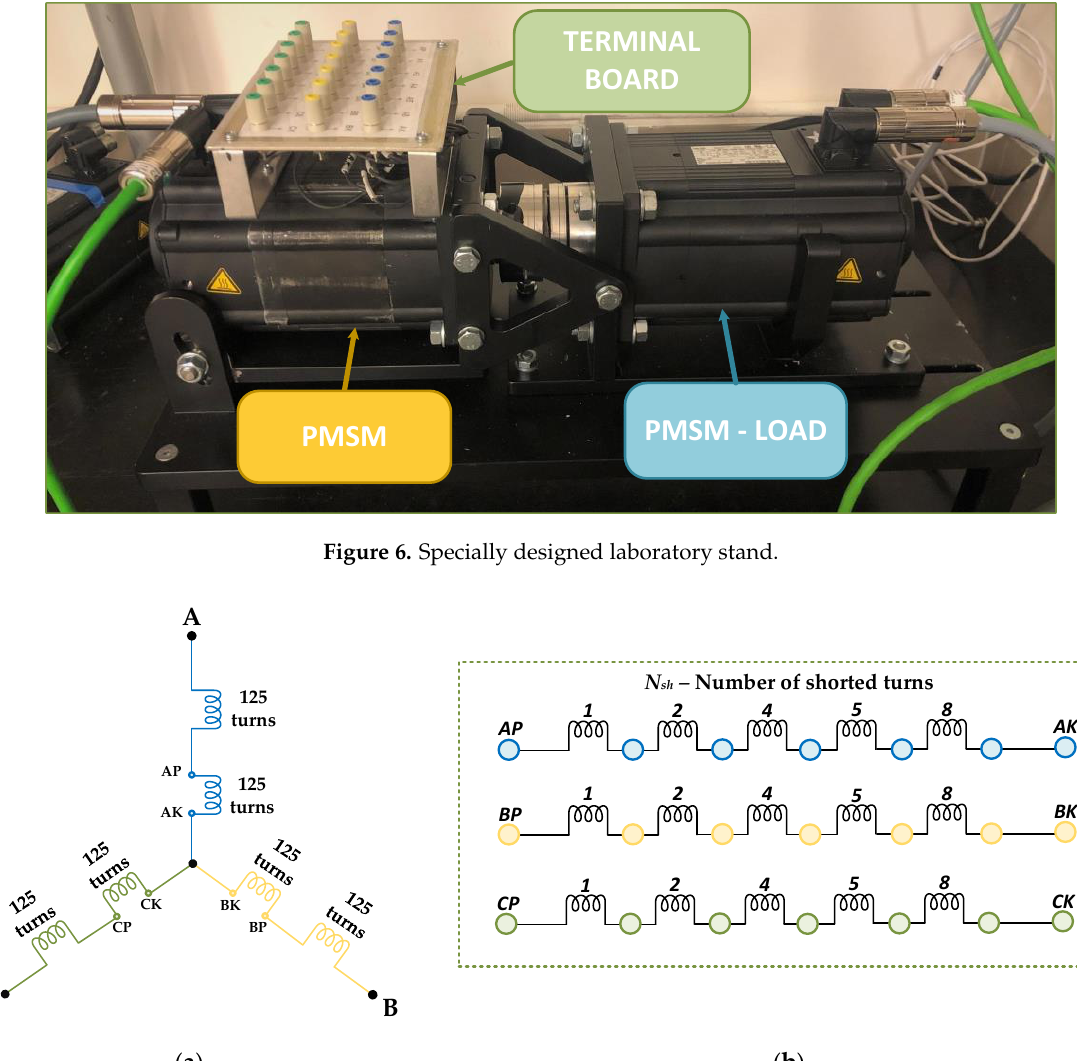
Figure 7. Illustrative schema of the tested PMSM stator winding ( a , b ) diagram of the derived phase terminals of the PMSM stator winding.